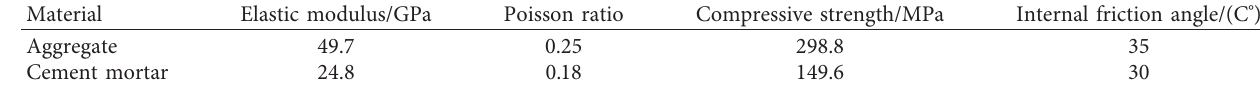
Table 1: Concrete mesoscopic medium material parameters